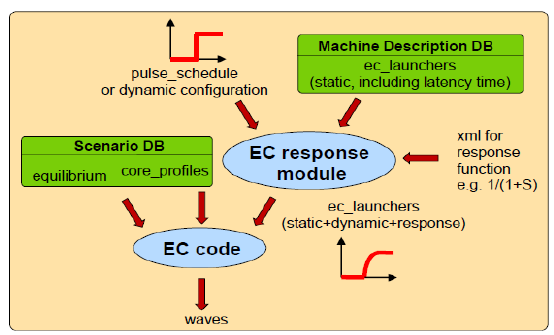
Fig. 8. EC modelling using Scenario and Machine Description data combined with dynamic waveforms configured by a pulse